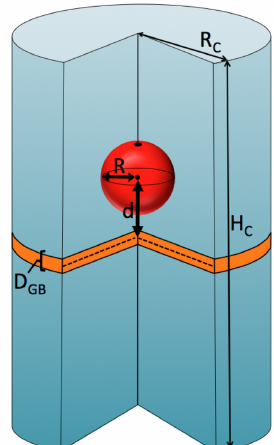
Figure 7. Illustration of the concept for the calculation of the stored elastic energy. The (coherent) precipitate of radius R is located at a distance d away from a grain boundary (center-to-center distance), which has a thickness D GB . The entire FEM simulation domain has a cylindrical geometry with a radius R c (cid:29) R , such that the mantle surfaces do not influence the precipitate. All surfaces are traction